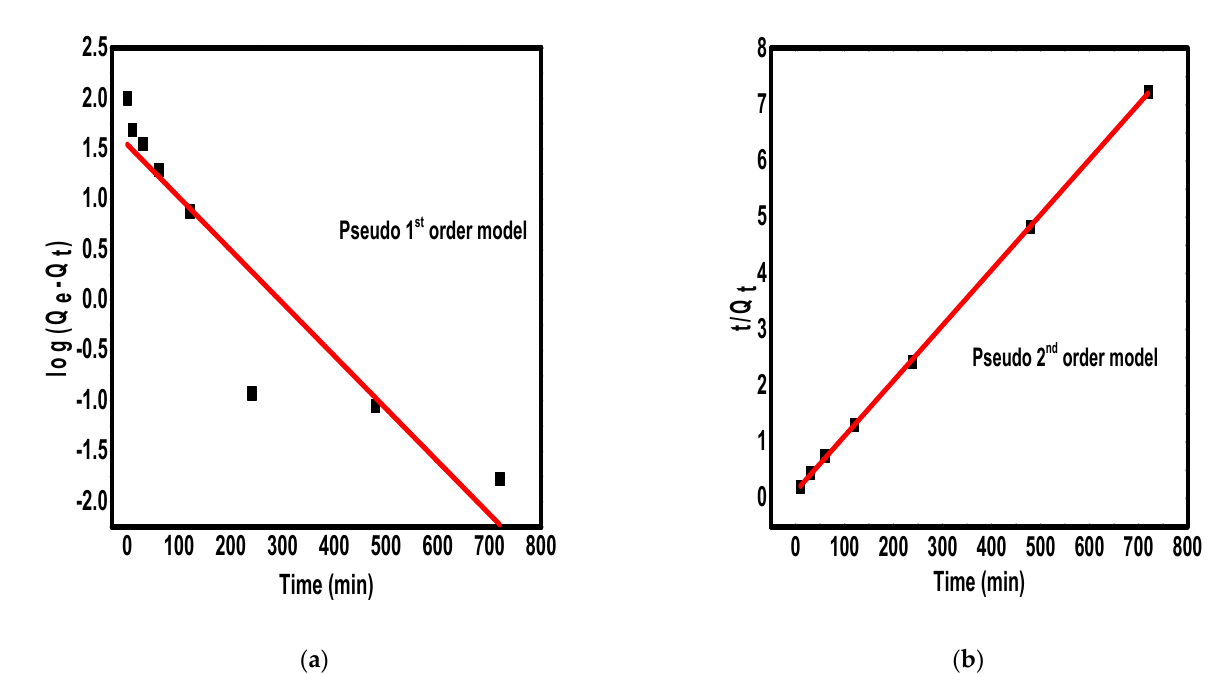
Figure 5. The pseudo-first-order kinetic model ( a ) and pseudo-second-order kinetic model ( b ) for the adsorption of Pb 2+ ions on the surface of Fe 3 O 4 /N@C nanocomposite. Table 1. The adsorption isotherm and kinetic parameters for the adsorption of Pb 2+ ions on the surface of Fe 3 O 4 /N@C